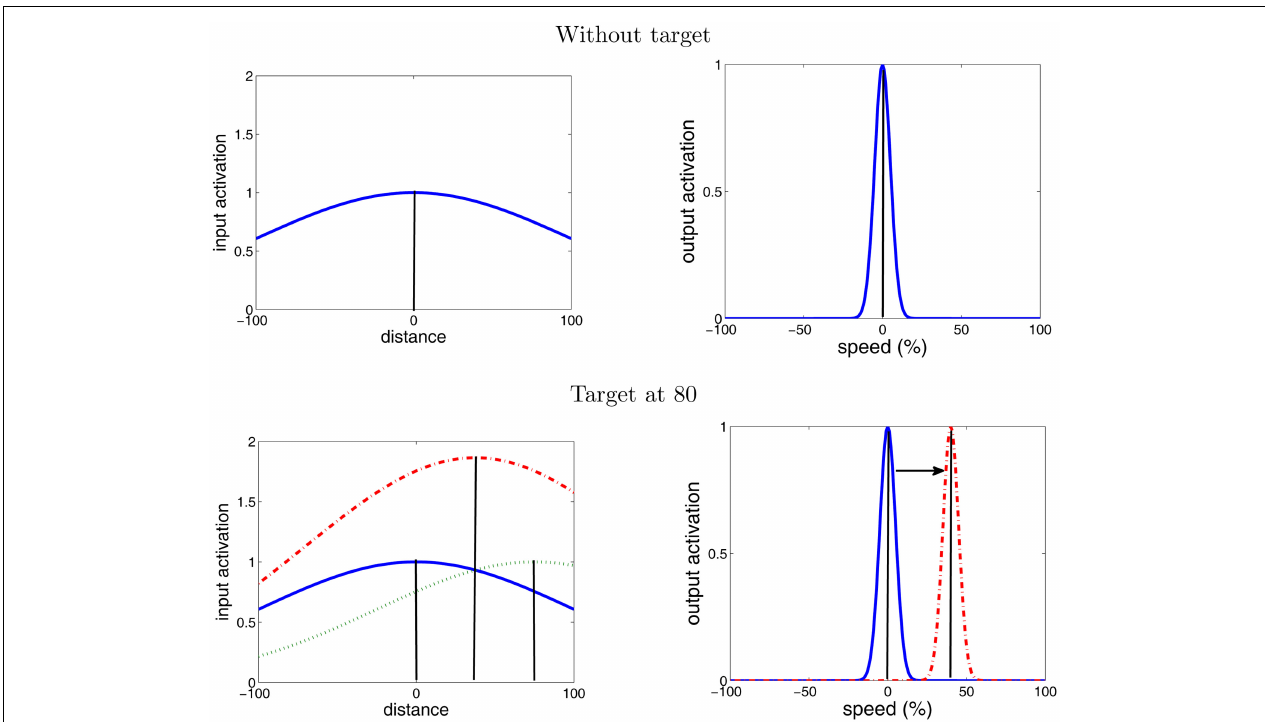
(dashed green line) is added to the activation around the center (blue line) resulting in a combined activation (red dashed line).This new input activation causes the output activation to move toward the new input maximum leading to an increase of the end effector’s speed (“Moving blob”